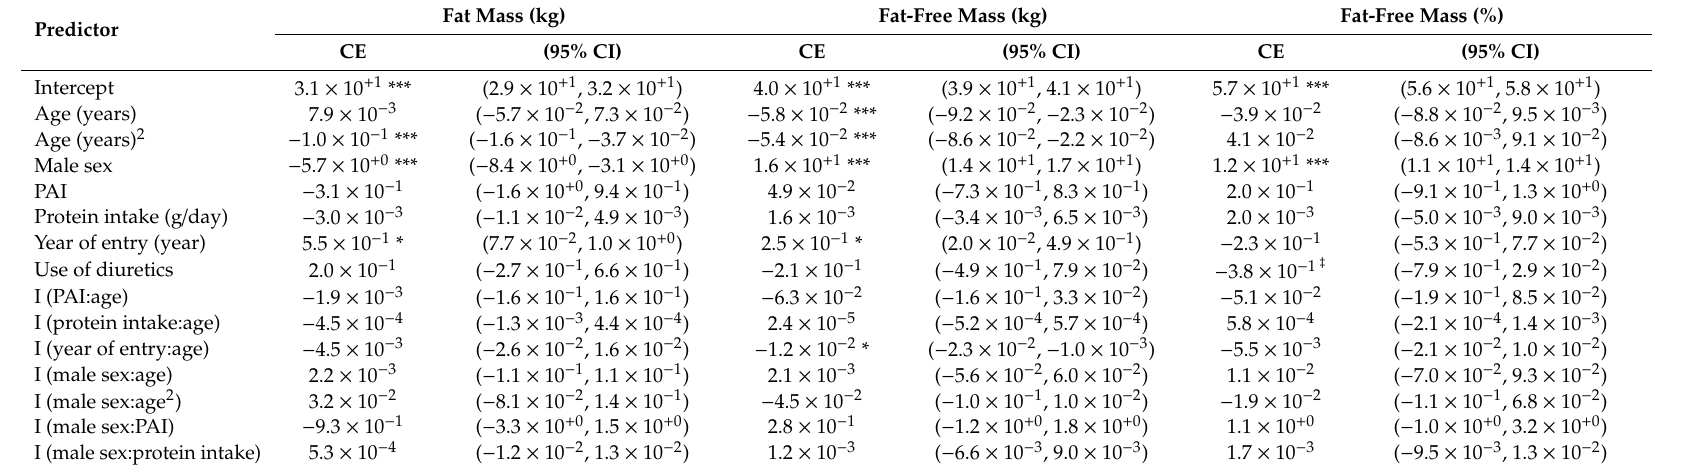
Table 4. Predictors in linear mixed-e ff ects models for body composition ( n =